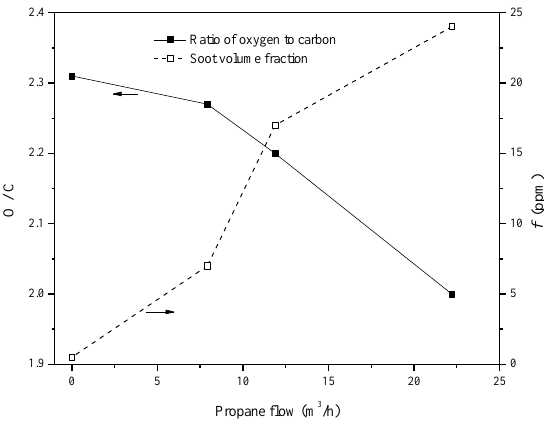
Figure 13. The ratios of oxygen to carbon and soot volume fractions of four cases.